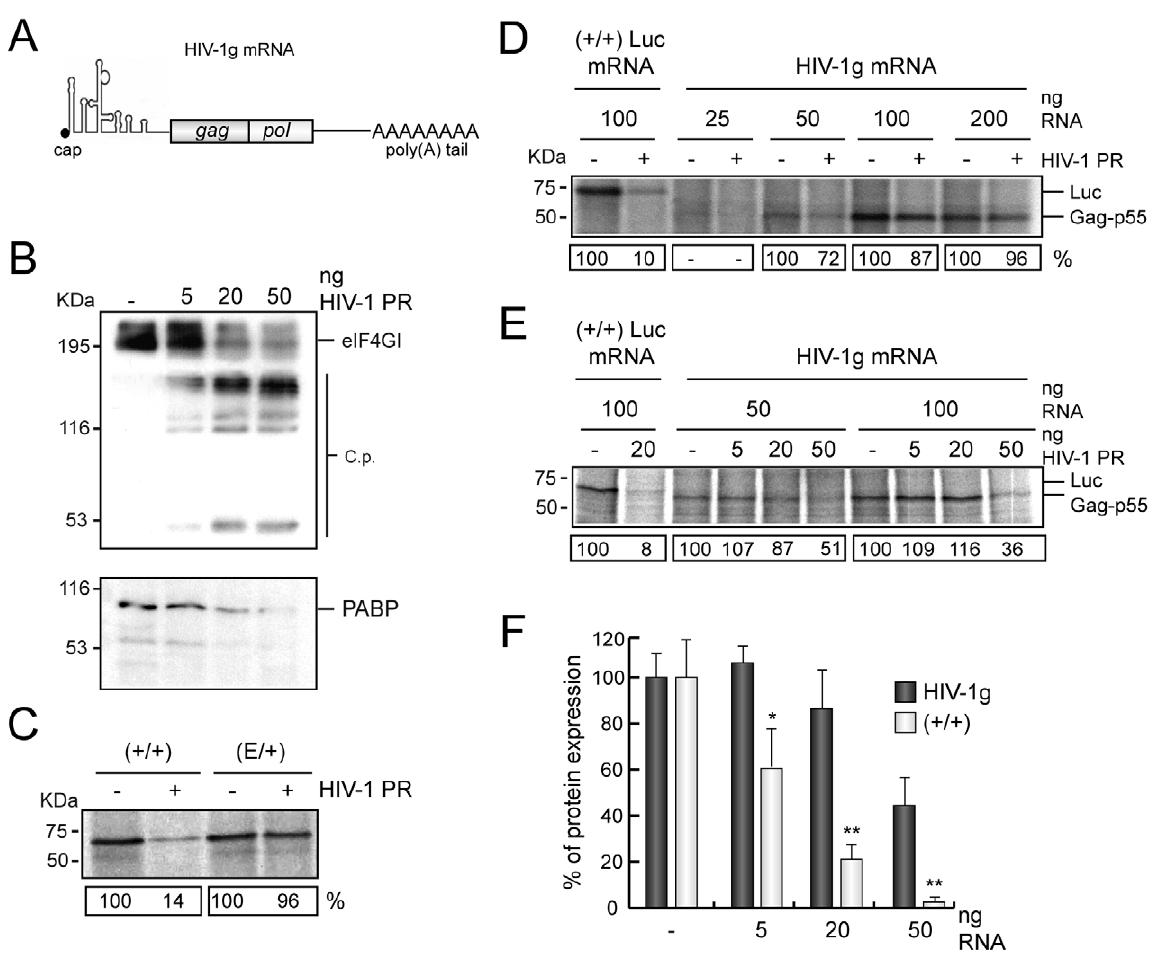
Figure 6. Translation of HIV-1g mRNA in presence of HIV-1 PR. A) Schematic representation of HIV-1g mRNA, indicating the structures of the leader sequence and the open reading frames encoded. B) HeLa extracts were programmed with different doses of HIV-1 PR (5, 20 and 50 ng). eIF4GI and PABP were analyzed by western blot after 30 min of incubation. C) HeLa extracts supplemented with [ 35 S]Met-[ 35 S]Cys were pre-incubated with 20 ng HIV-1 PR for 30 min. Extracts were then incubated with 2.5 m M SQ and programmed with 100 ng ( + / + ) or (E/ + ) luc mRNAs. Translation reaction was stopped after 1 h and protein synthesis was analyzed by SDS-PAGE followed by fluorography and autoradiography. D) HeLa extracts supplemented with [ 35 S]Met-[ 35 S]Cys were pre-incubated with 20 ng HIV-1 PR for 30 min. Extracts were then incubated with 2.5 m M SQ and subsequently programmed with 20, 50 100 or 200 ng HIV-1g mRNA or 100 ng ( + / + ) luc mRNA. Translation reaction was stopped after 1 h and protein synthesis was analyzed by SDS-PAGE followed by fluorography and autoradiography. The data shown in this figure is a representative experiment of a set of three independent experiments. E) HeLa extracts supplemented with [ 35 S]Met-Cys were pre-incubated with 5, 20 or 50 ng HIV-1 PR for 30 min. 2.5 m M SQ was added to the reaction mixture and next, extracts were programmed with 50 or 100 ng HIV-1g mRNA or 100 ng ( + / + ) luc mRNA. Translation reaction was stopped after 1 h and protein synthesis was analyzed by SDS-PAGE followed by fluorography and autoradiography. The data shown is a representative experiment of a set of two independent experiments. F) Comparative representation of Gag or Luc synthesis after pre-incubation with increasing amounts of HIV-1 PR (5, 20 and 50 ng). SD, were obtained from two independent experiments. *P , 0.05; **P , 0.01.